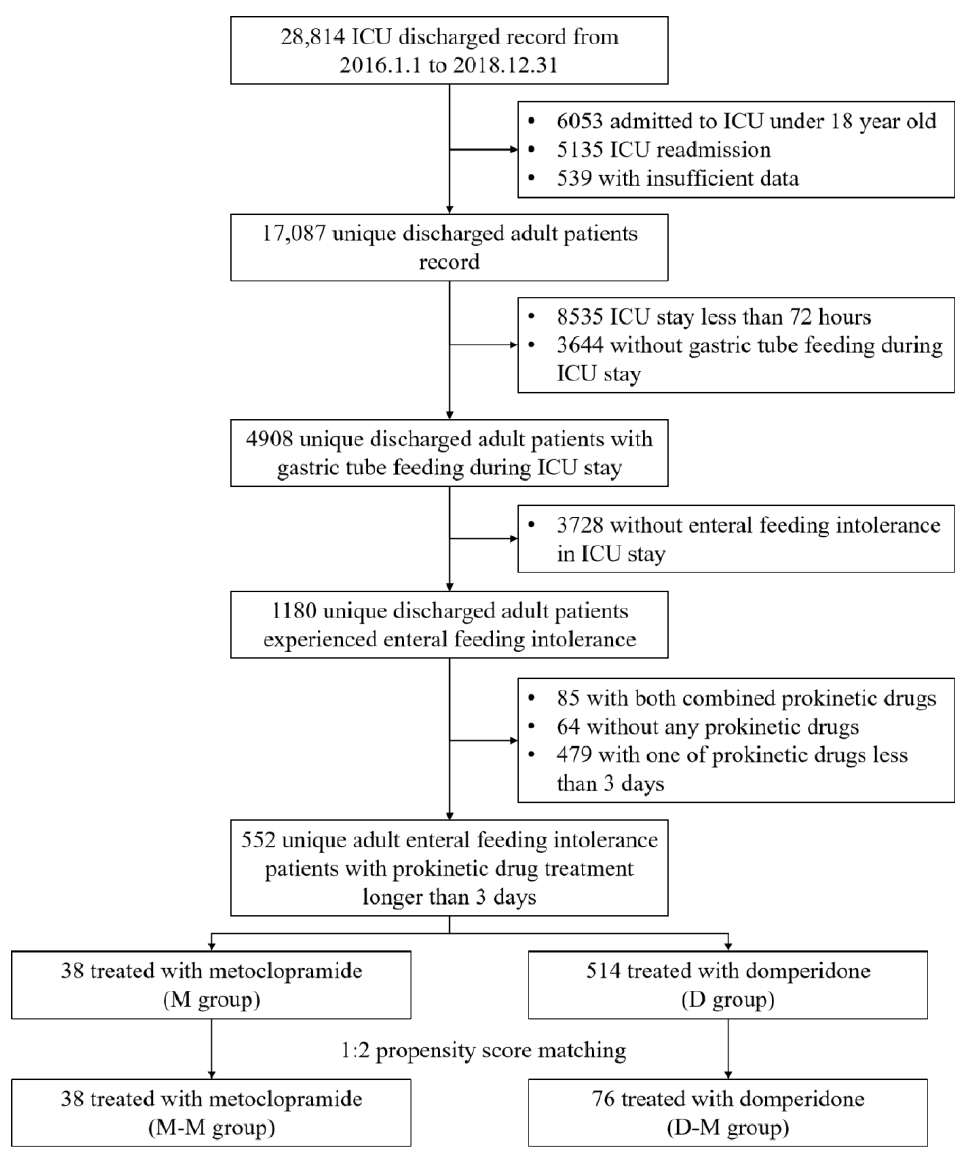
Figure 1. Study profile. Table 1. Baseline characteristics.